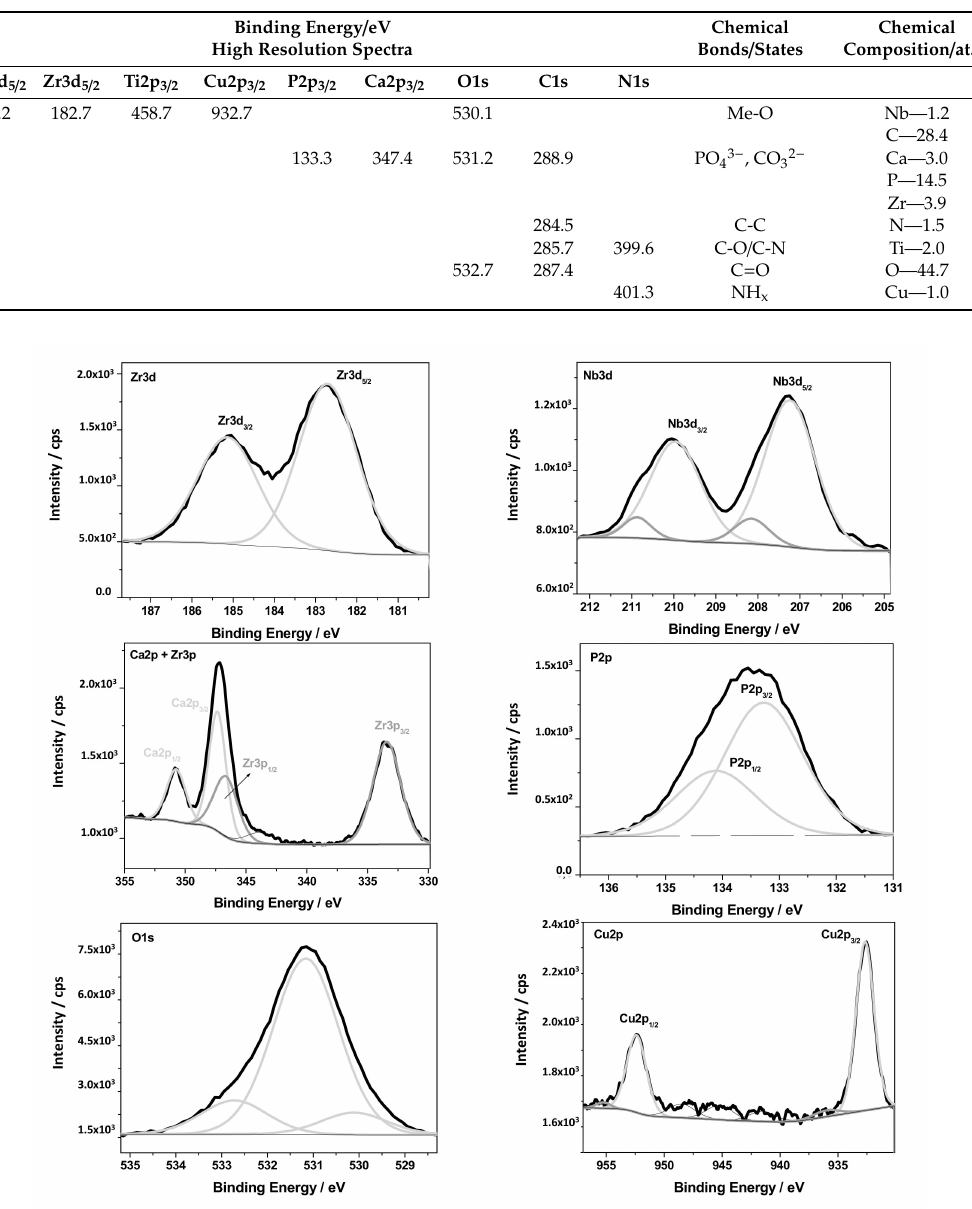
Figure 6. The high resolution XPS spectra after the deconvolution